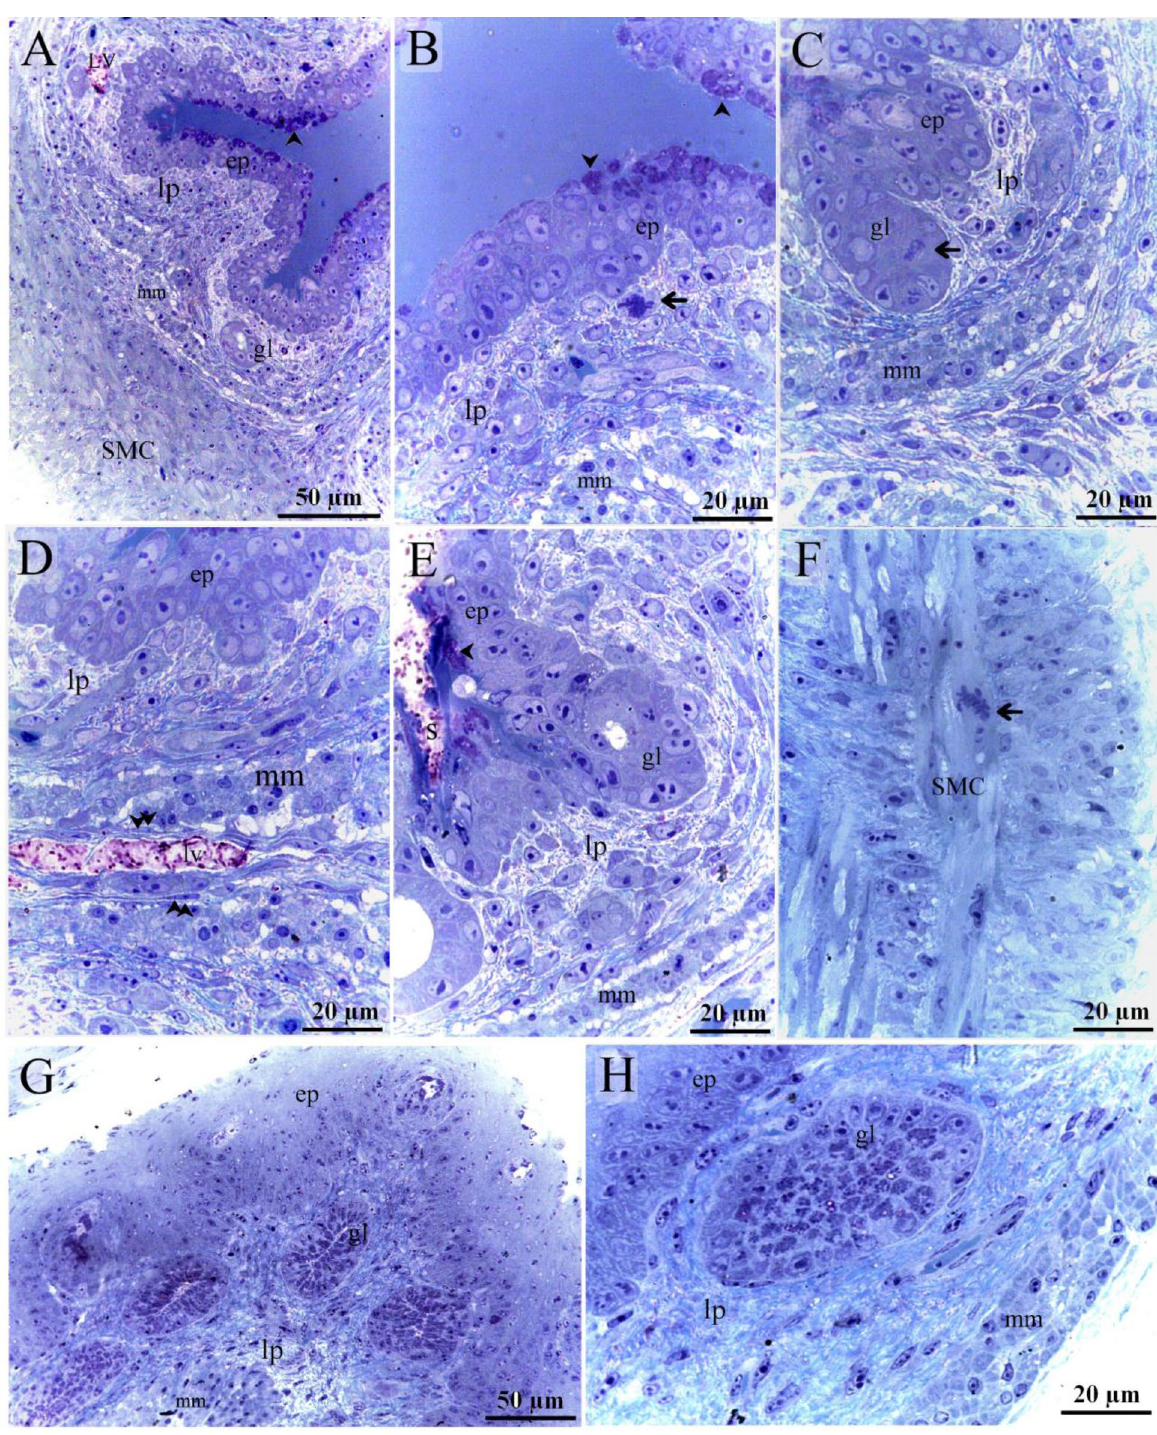
Figure 7. Semi-thin sections of days 13 and 15 stained by toluidine blue. Semi-thin sections of days 13 ( A – F ) and 15 ( G , H ) stained with toluidine blue. ( A – F ) The esophagus lined by pseudostratified epithelium (ep) which contained mucous producing cells. Note metachromatic granules (arrowheads), inactive gland (gl), lamina propria (lp), muscularis mucosae (mm), smooth muscle cells of tunica muscularis (SMC), blood vessels (bv), Telocytes (double arrowheads). Metachromatic section (s) at the epithelial surface and inside the lymph vessels (lv). Mitotic divisions (arrows). ( G , H ) The esophagus developed stratified squamous epithelium (ep) and active mucous glands (gl). Note lamina propria (lp), muscularis mucosae